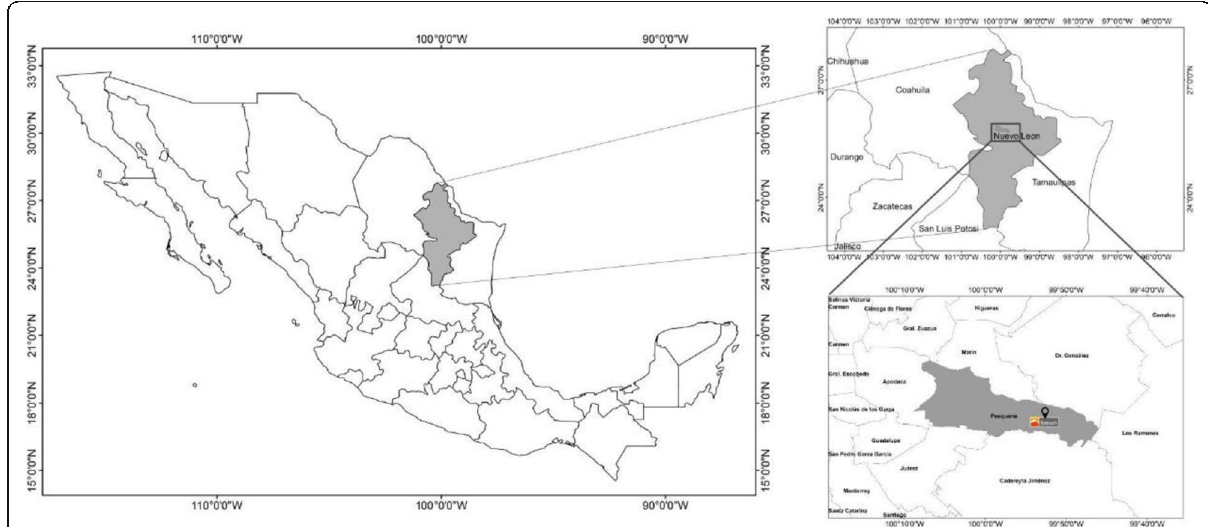
Fig. 1 Location of the study area. On the left side, the Mexican Republic is indicated, on the upper right side the superior right the State of Nuevo Leon is indicated, and on the lower right side the Municipality of Pesquería is